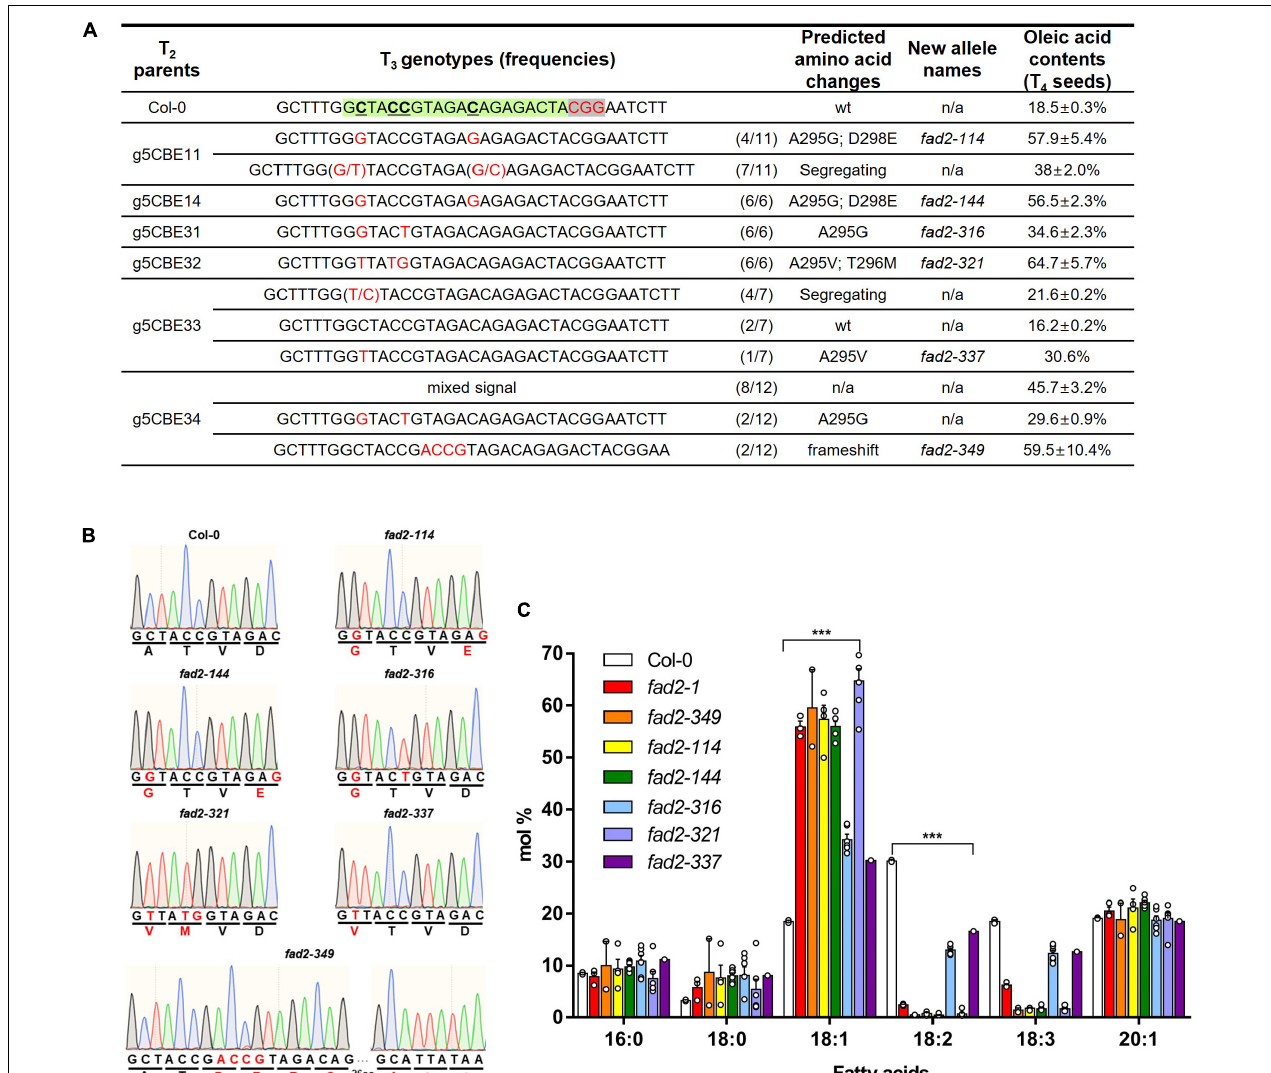
FIGURE 3 | Characterization of the base-edited fad2 alleles . (A) A summary of T 3 segregation patterns and analyses of oleic acid contents depending on each genotype. Green and gray letterboxes denote protospacer sequence and PAM sequence, respectively. Red letters indicate altered DNA sequences. According to fixed genotypes, novel fad2 alleles were defined with predicted amino-acid changes. (B) Chromatogram results from Sanger sequencing for FAD2 genotyping within editing windows in the defined fad2 alleles. Red letters indicate altered DNA and amino-acid sequences. (C) Comparison of fatty acid compositions between T 4 seeds from novel fad2 alleles, fad2-1 , and Col-0. A one-way ANOVA statistical analysis was used to identify differences between the Col-0 and fad2 alleles (*** p < 0.001). Values represent mean ±